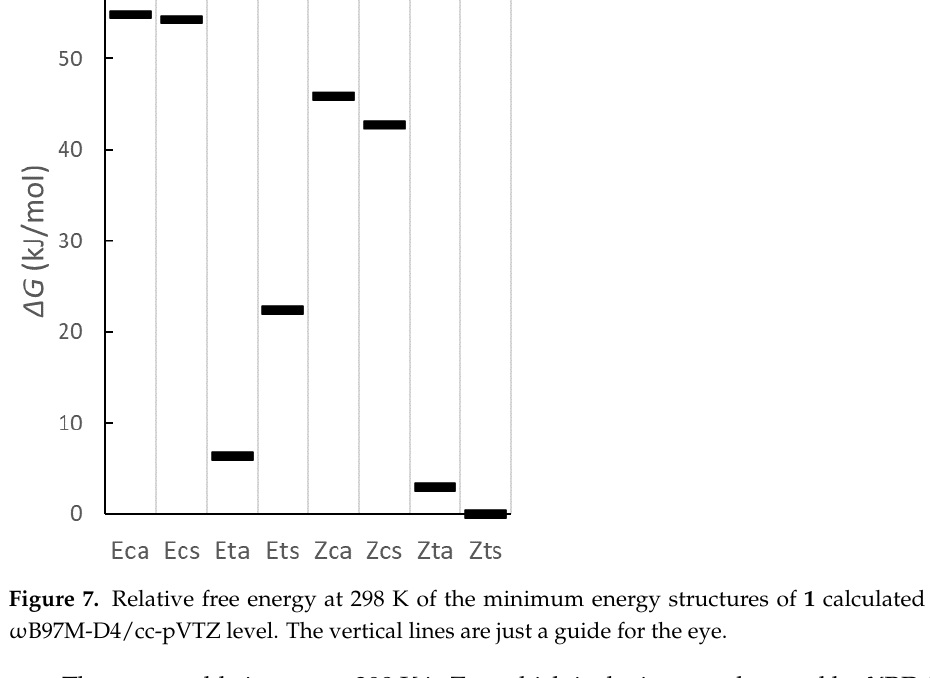
The most stable isomer at 298 K is Zts, which is the isomer observed by XRD in the